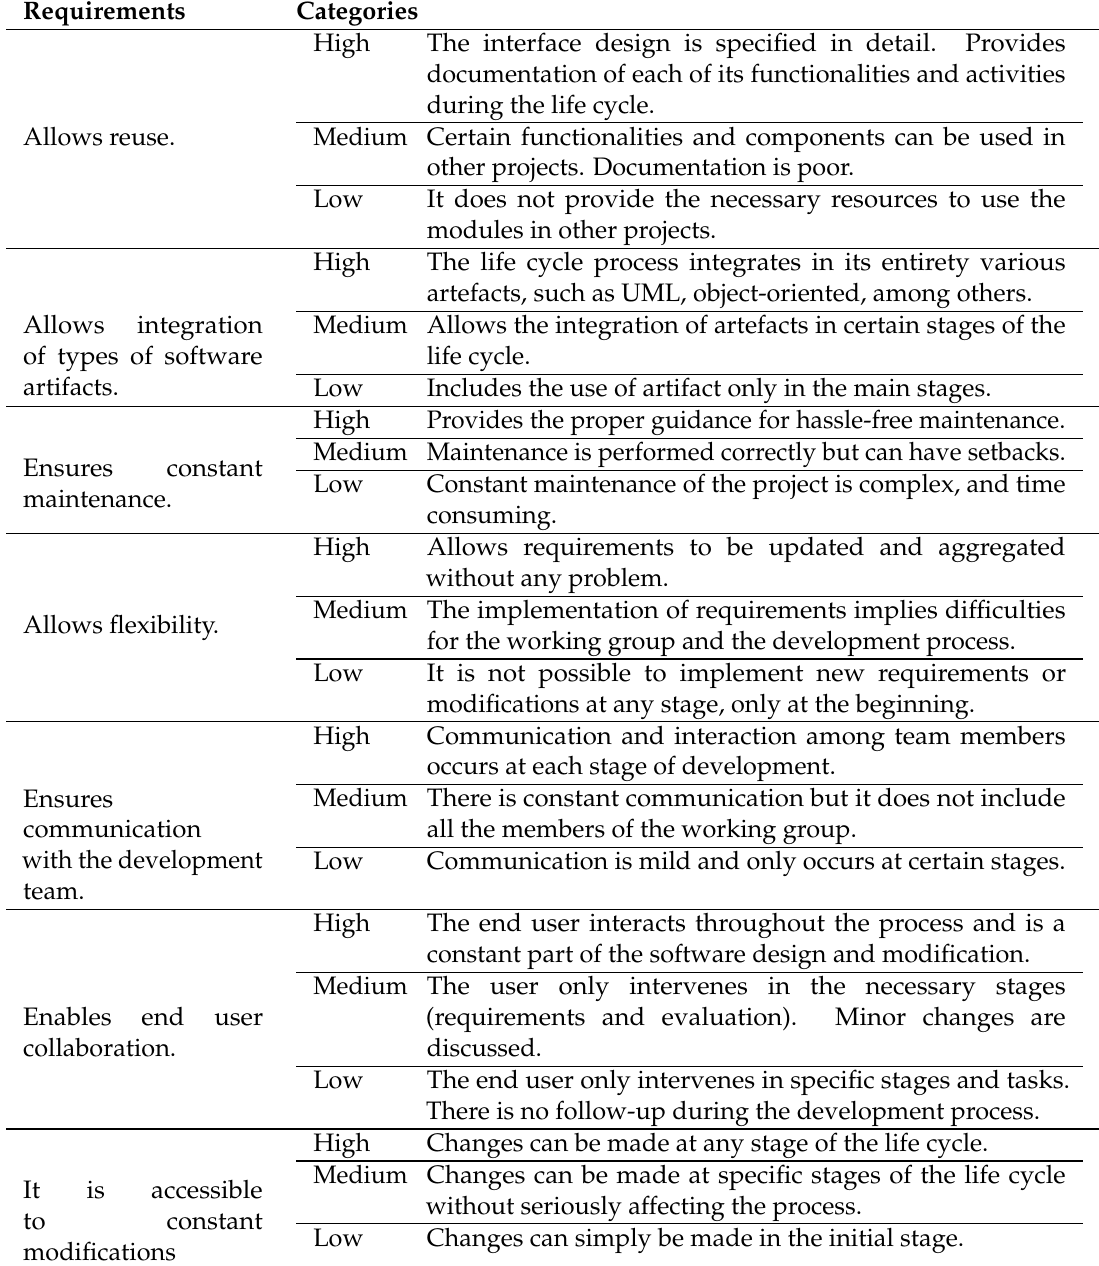
Table 12. Comparison of the methodologies within the perspective of agile development